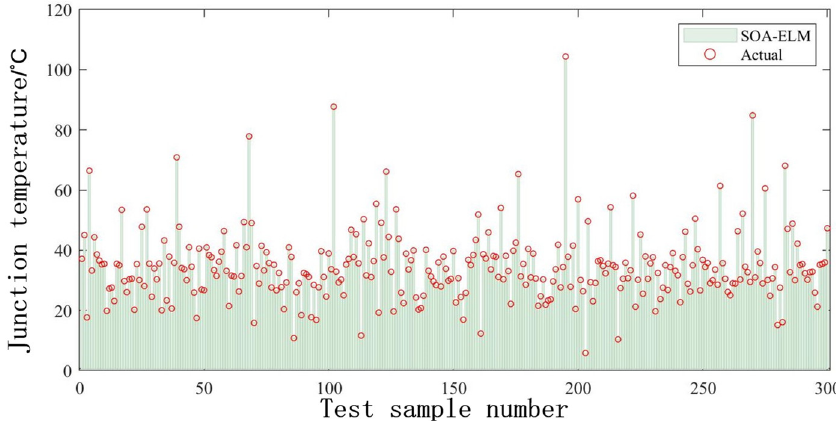
Figure 10. Predicted junction temperature of the SOA-ELM model.